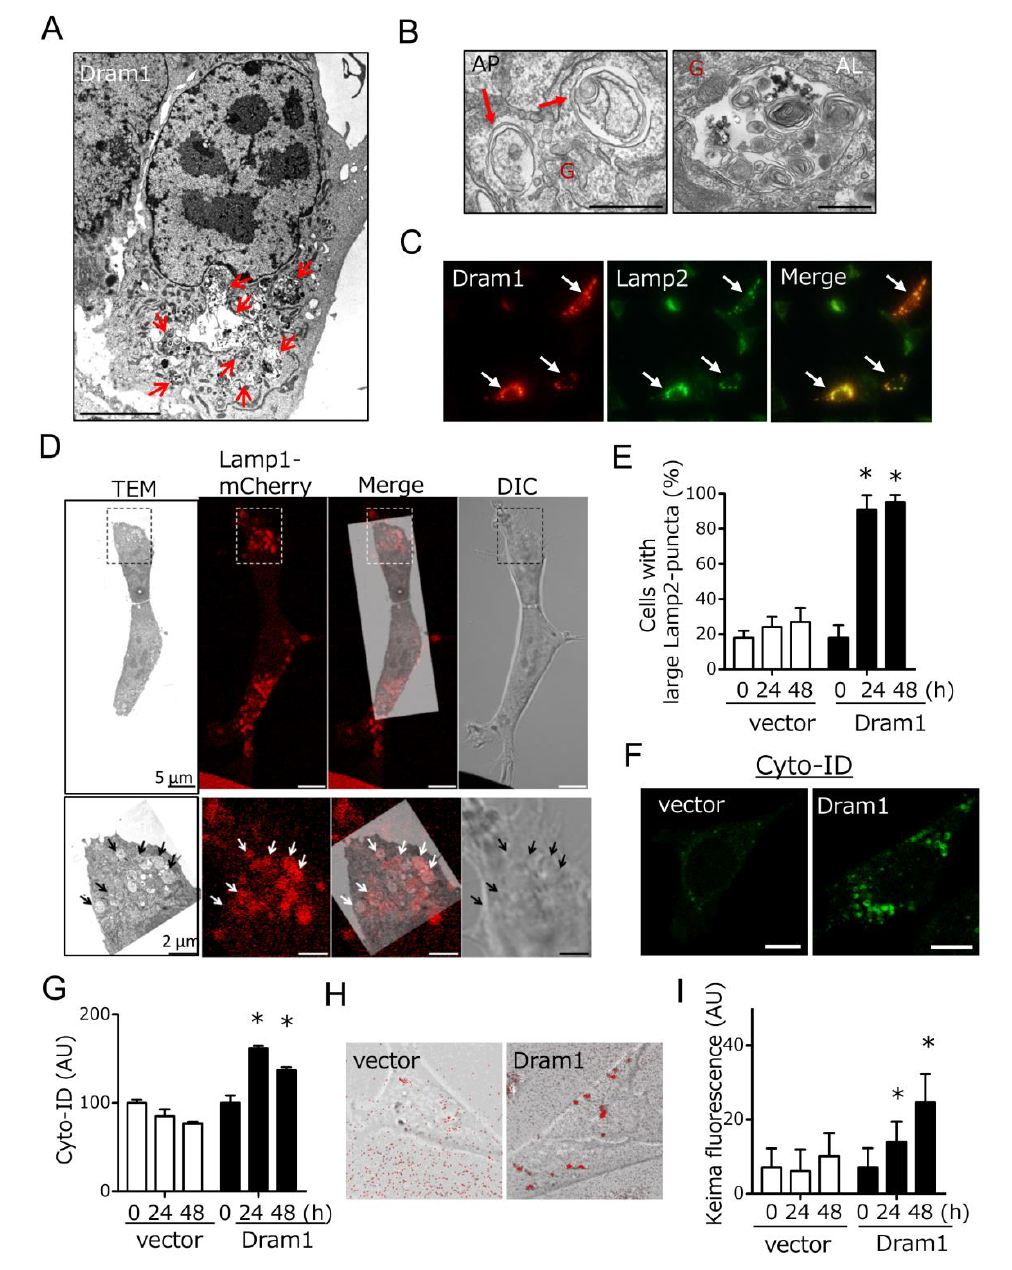
FIGURE 3: Induction of alternative autophagy in Atg5 KO MEFs by Dram1 expression. (A, B) Electron micrographs of Atg5 KO MEFs 12 h after the transfection of dram1-flag . In (A) , arrows indicate autolysosomes. Bar = 5 µm. In (B) , a representative autophagosome (AP, left) and autolysosome (AL, right) are shown. Arrows indicate autophagosomes. “G” indicates Golgi membranes. Bar = 0.5 µm. (C-E) Induction of alternative autophagy by Dram1 was assessed by Lamp2 immunostaining. In (C) , Atg5 KO MEFs were transfected with dram1-flag for 24 h. The cells were then analyzed for immunofluorescence of Lamp2 and Flag. Arrows indicate Atg5 KO MEFs in which Dram1 was efficiently transfected. (D) Identification of autolyso- somes as Lamp1-positive structures by CLEM. Lamp1-mCherry-expressing Atg5 KO MEFs were transfected with dram1-flag , and were incubated for 24 h. Then CLEM analysis was performed. The magnified images of the dashed squares are shown in the bottom panels. Lamp1-positive structures (red signals; arrows) were identical to large autolysosomes. (E) Atg5 KO MEFs were transfected with dram1-flag or control vector for the indicated times. The cells were then analyzed for immunofluorescence of Lamp2 and Flag. The percentage of cells with punctate Lamp2 immunofluorescence is shown as the mean + SD (n = 4). *p < 0.05 vs the value of “vector 0 h”. (F-I) Induction of alternative autophagy in etoposide-treated Atg5 KO MEFs by Dram1. Atg5 KO MEFs were transfected with dram1-flag or control vector for the indicated times. Alternative autophagy was then ana- lyzed using Cyto-ID (F, G) and Keima (H, I) . In (F) and (H) , representative images at 24 h are shown. The extent of Cyto-ID fluorescence (G) and Kei- ma fluorescence (I) is shown as the mean + SD (n = 4). *p < 0.05 vs the value of “vector 0